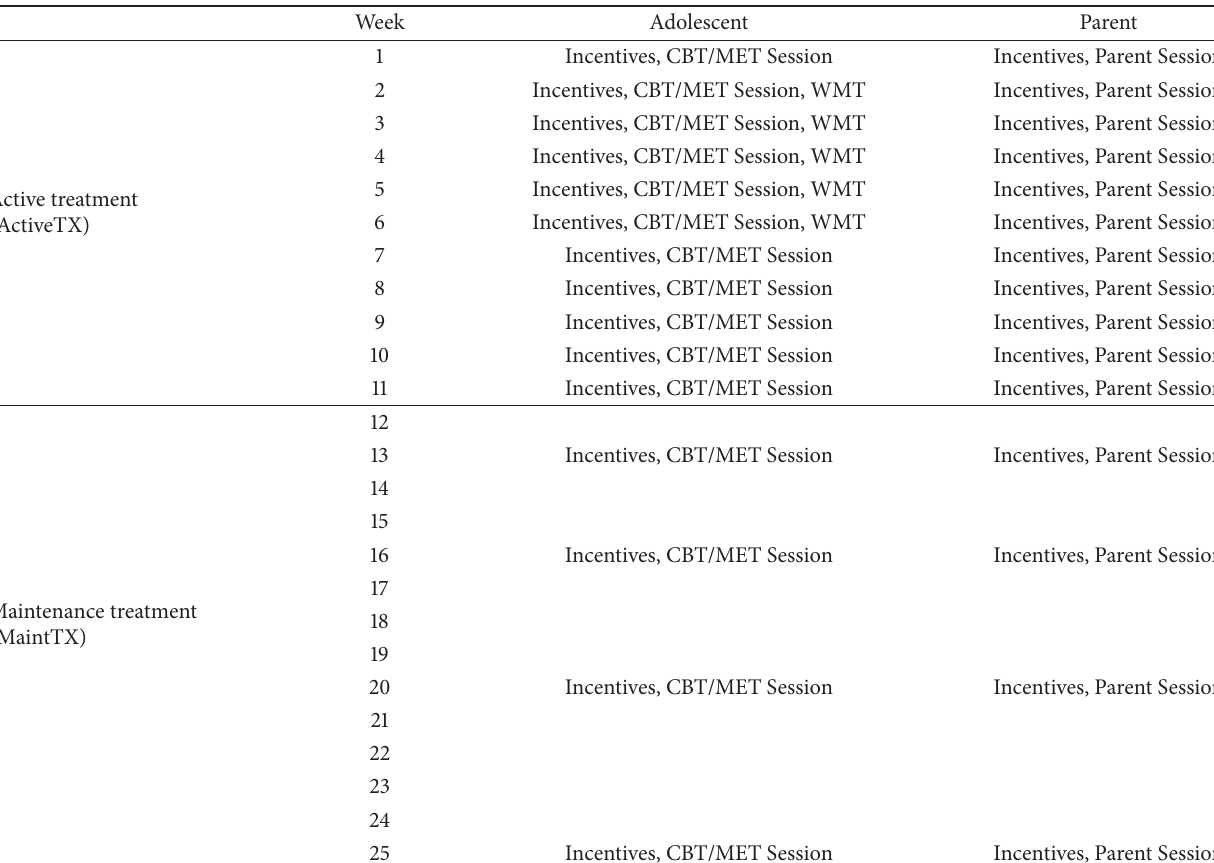
Table 1: Treatment